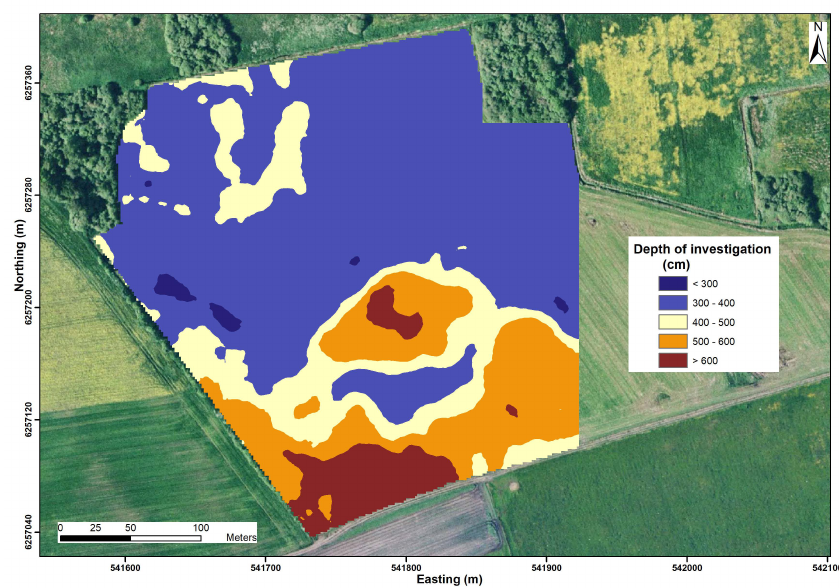
Figure 9. Depth of investigation (DOI) for the calculated true electrical conductivity ( σ smooth ) estimates over the study area.